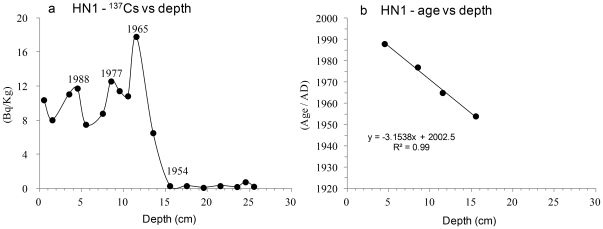
Chronology of HN1 by 137Cs dating.(a), 137Cs signal in the sediments of HN1. (b), 137Cs determined age versus depths in HN1.